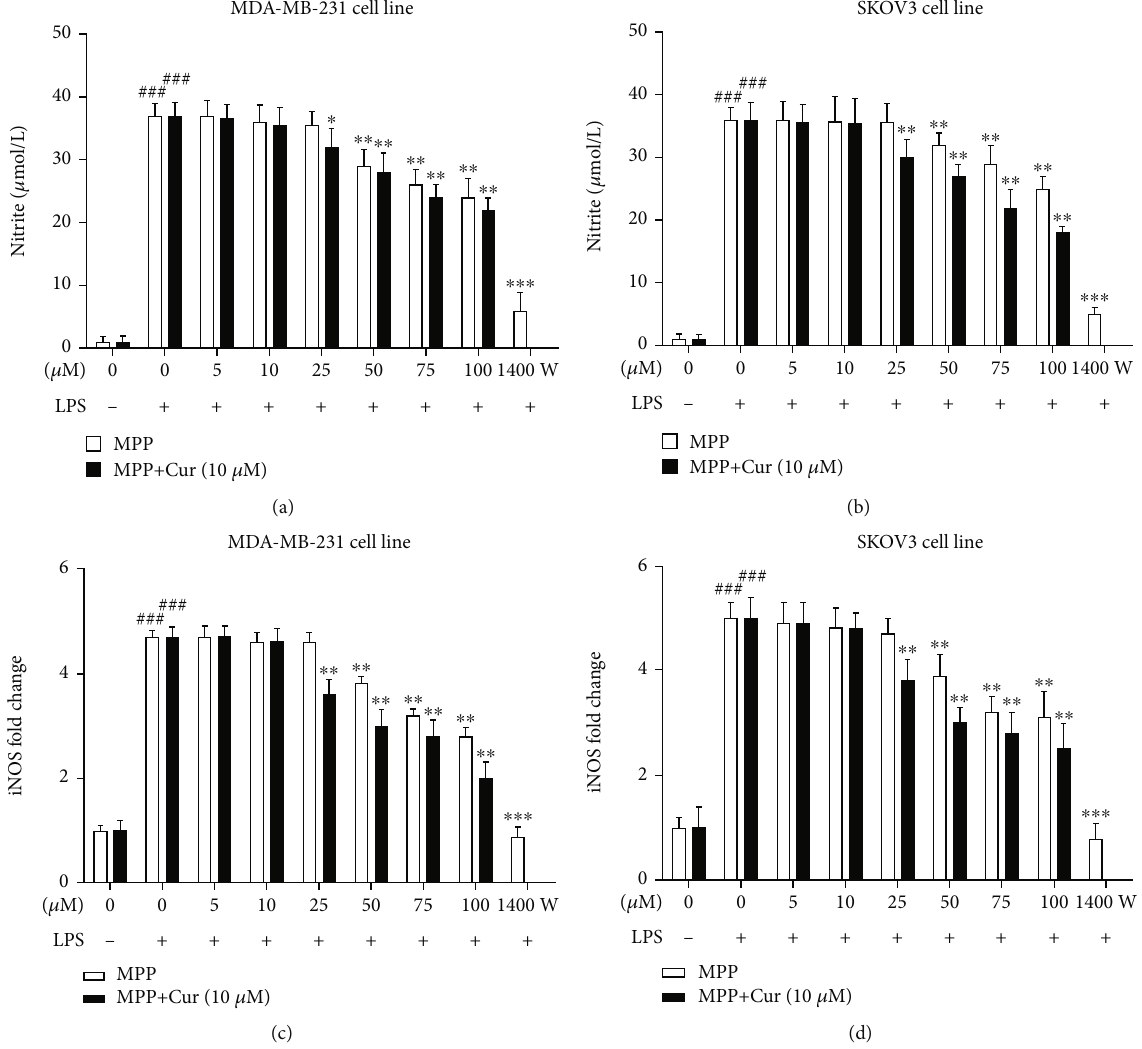
Figure 6: The levels of nitrite as the marker of NO production in LPS-stimulated (a) MDA-MB-231 and (b) SKOV3 cell lines. The gene expression of INOS in LPS-stimulated (c) MDA-MB-231 and (d) SKOV3 cell lines, measured by real-time PCR. ### P < 0 : 001 compared with untreated unstimulated control cells; asterisks indicate comparison with LPS-stimulated untreated cells ( ∗ P < 0 : 05 , ∗∗ P < 0 : 01 , and ∗∗∗ P < 0 : 001 ); ### P < 0 : 001 compared with untreated unstimulated control cells. The experiment was repeated at least three times